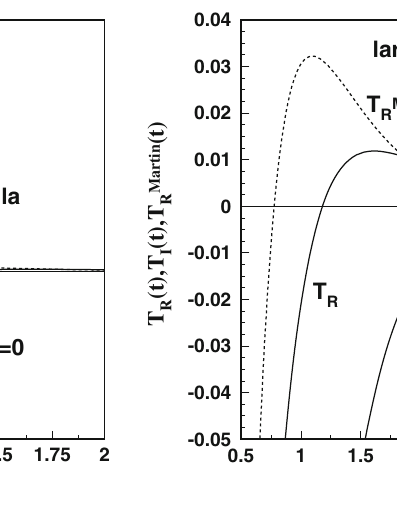
Fig. 13 Martin’s Real Part Formula. a | t | dependence of the real part of elastic amplitude calculated with Martin’s Formula T Martin theimaginarypart T I ( t ) ofKFKmodel,comparedwith T R ( t ) ,bothnor- malized to 1 at | t | = 0; b large | t | behaviour of T R ( | t | ) and T I ( | t | ) of